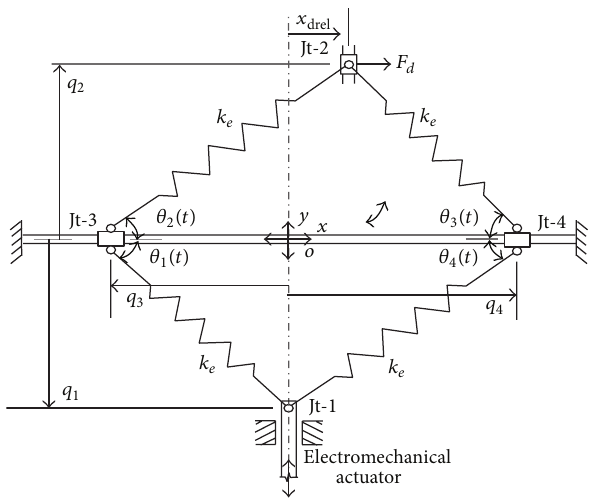
Figure 2: Schematic of SAVS with TMD displaced.